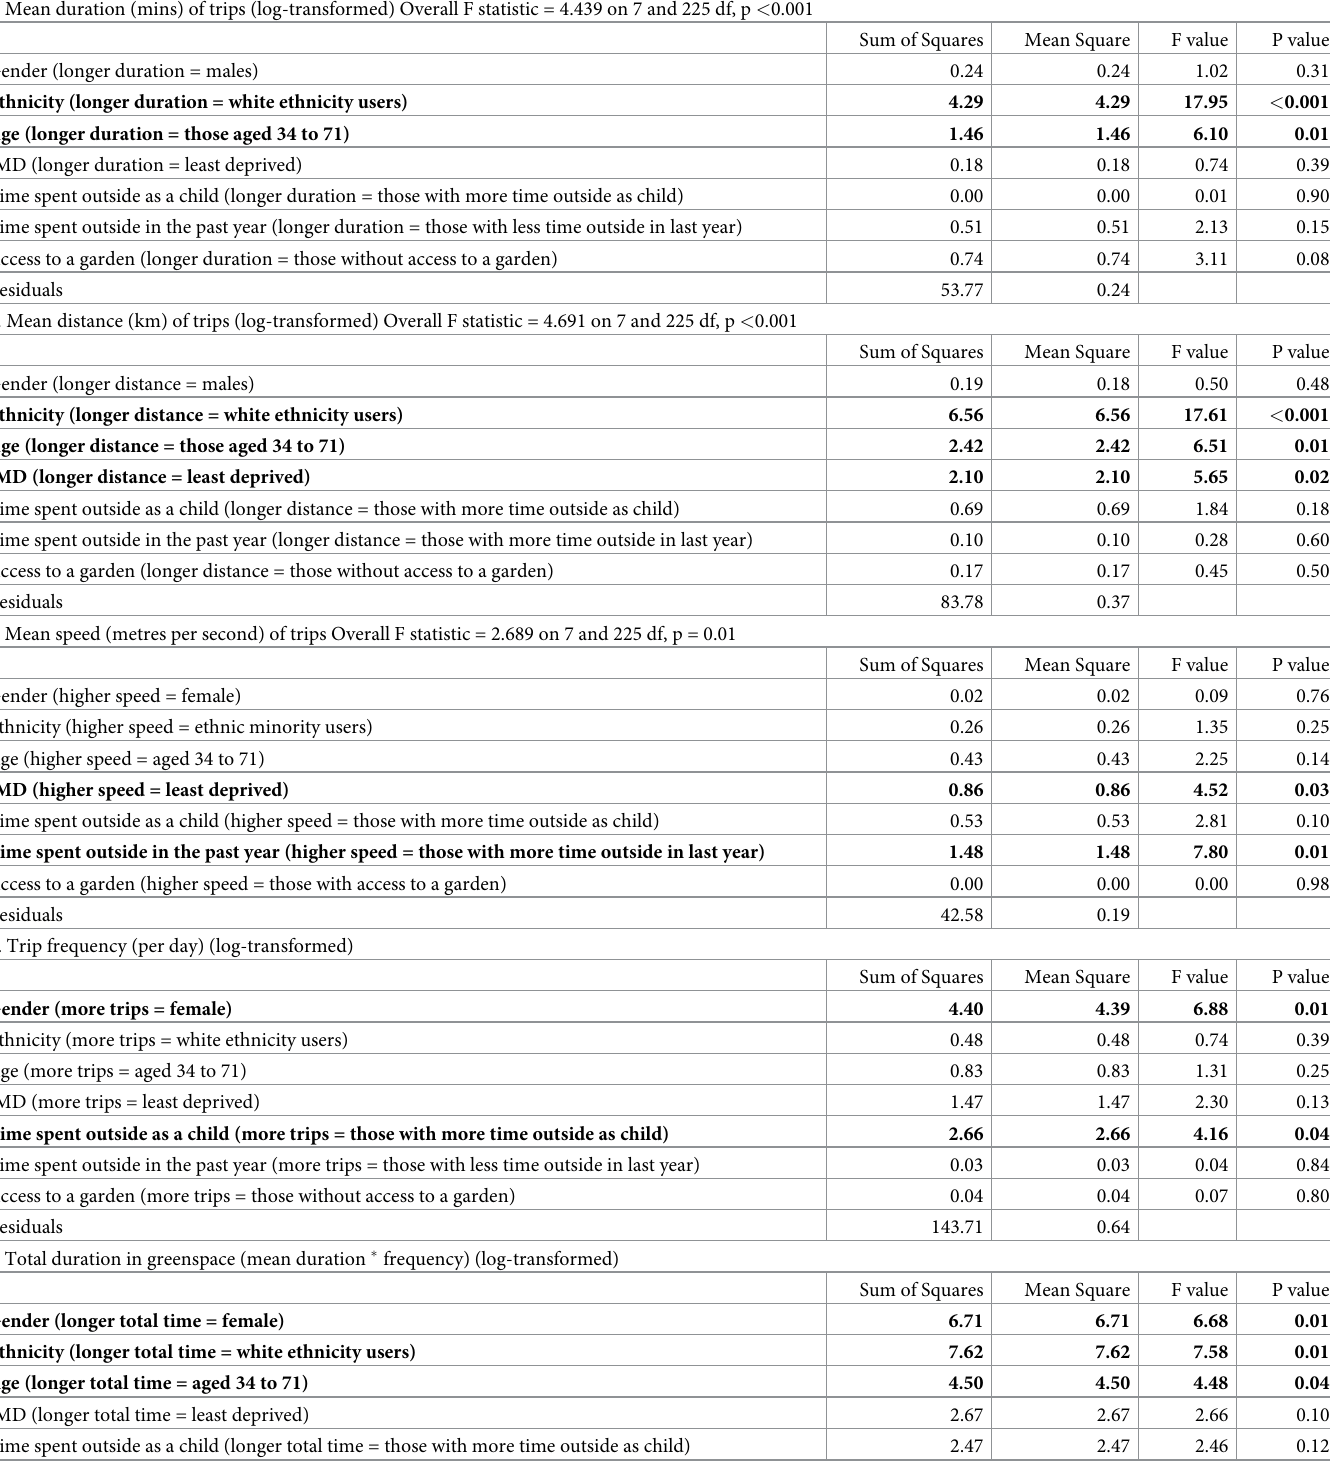
Table 7. Results of ANOVAs testing relationships between demographic factors and trip characteristics for (a) mean duration; (b) mean distance; (c) mean speed; (d) trip frequency; (e) total duration in greenspace; and (f) total distance in